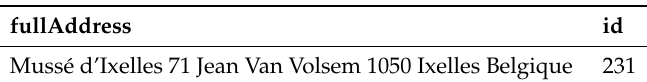
Table 3. Concatenation of tuples in Table